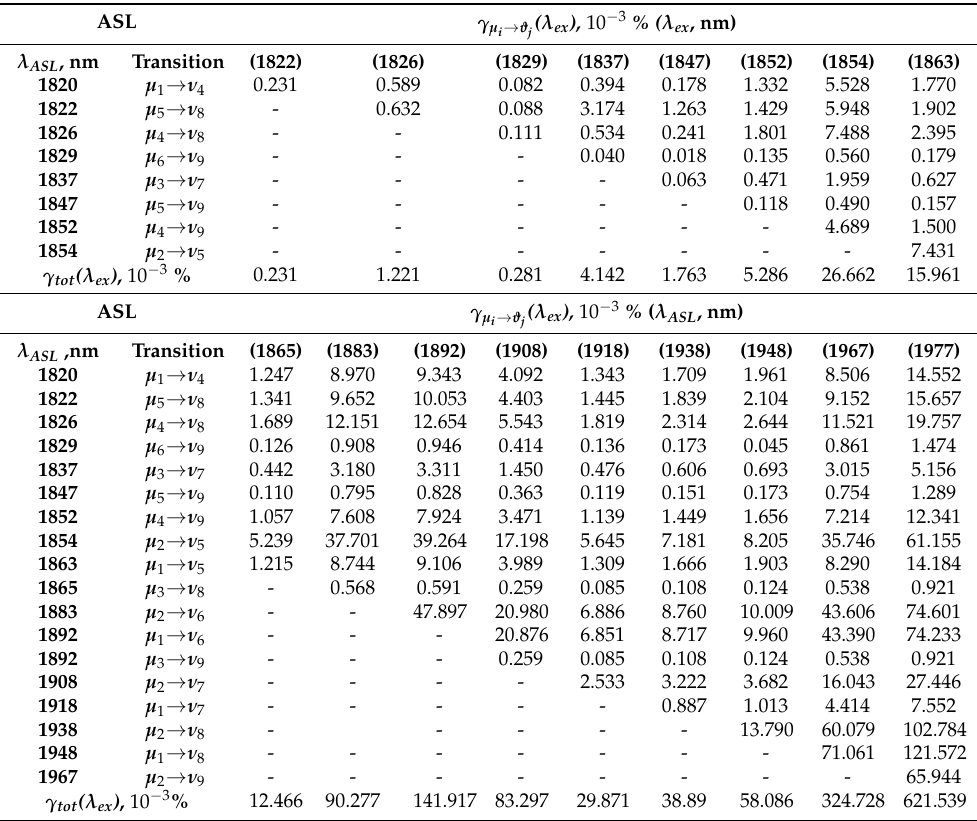
Table 3. Set of ASL wavelengths satisfying condition (1) at a fixed excitation